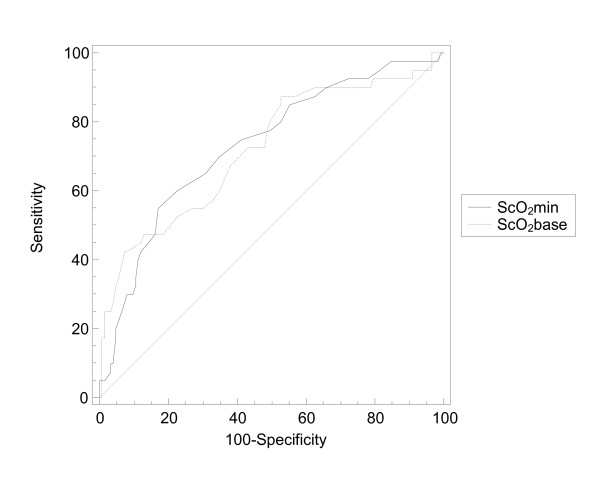
Comparison between receiver operating characteristic curves for preoperative oxygen-supplemented ScO2 and minimal intraoperative ScO2 on delirium. ScO2, regional cerebral oxygen saturation; ScO2min, minimal intraoperative regional cerebral oxygen saturation; ScO2base, regional cerebral oxygen saturation with patient breathing 4 L per minute supplemental oxygen.